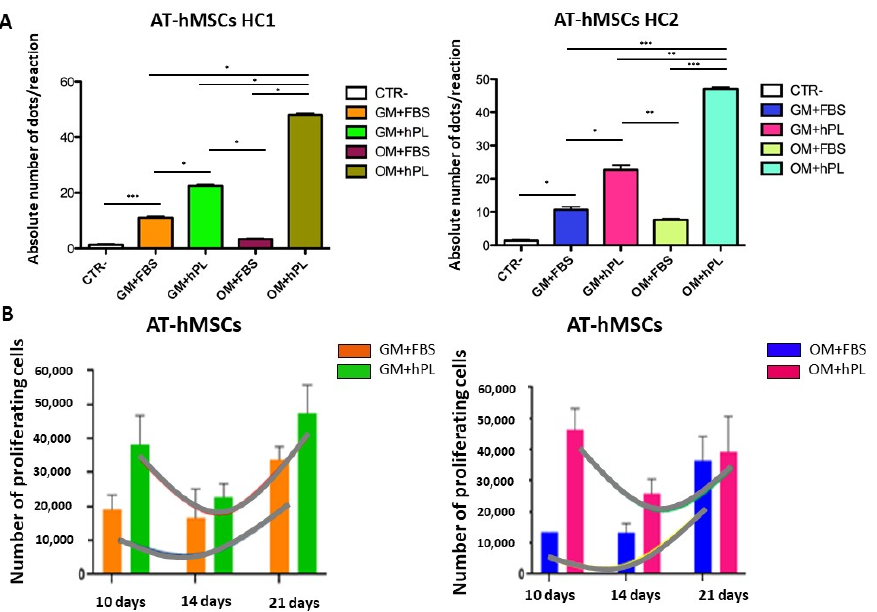
Figure 4. Osteogenic di ff erentiation of AT-hMSCs evaluated by OPN transcript absolute quantification. ( A ) The figure reports the absolute quantification of the OPN transcript level obtained by dPCR analysis of BM-hMSCs at 21 days. All conditions are reported: GM + FBS, GM + hPL, OM + FBS, OM + hPL, for HC1. GM + FBS, GM + hPL, OM + FBS, OM + hPL, for HC2. CTR- obtained by 2D culture of BM-hMSCs cultured with GM served as a negative control. Data are expressed as the absolute number of positive dots / reaction. Statistical significances calculated by t -tests with Welch’s correction (* p ≤ 0.05, ** p ≤ 0.01, *** p ≤ 0.001, **** p ≤ 0.0001); ( B ) BM-hMSCs proliferation trends. Proliferating BM-hMSCs cultured in HC1 in the presence of GM + FBS and in the presence of GM + hPL, and cultured in HC2 in the presence of GM + FBS and in the presence of GM + hPL are reported at di ff erent time points (10, 14, and 21 days). BM-hMSCs cultured with OM + hPL presented the highest quantity of the OCN transcript in both sca ff old HC1 and sca ff old HC2 (Sca ff old HC1 OM + hPL vs. GM + hPL, p = 0.0006; sca ff old HC1 OM + hPL vs. OM + FBS; sca ff old HC2 OM + hPL vs. GM + FBS, p = 0.0299; sca ff old HC2 OM + hPL